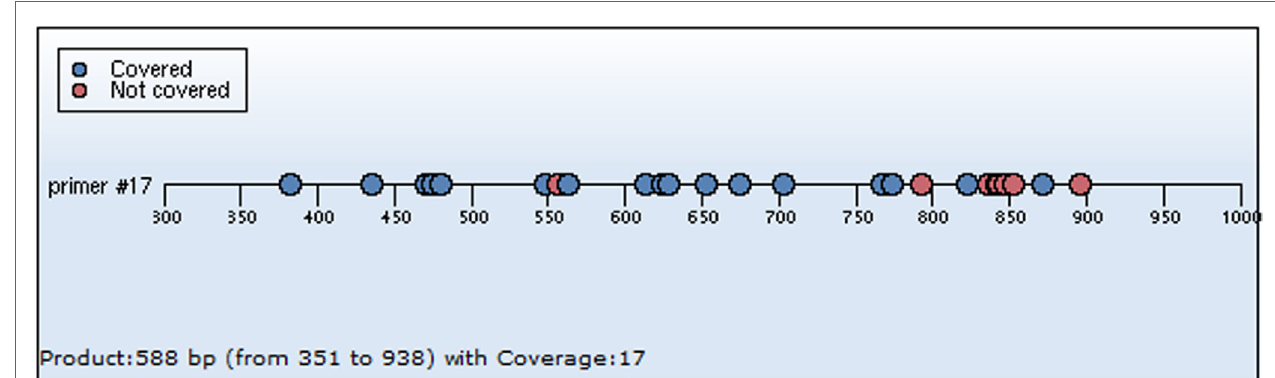
FigUre 2 | Primers were designed based on the sequenom ® EpiDesigner software system. The CpG sites at CpG Island one were involved in the primers design, performed with a program of BDNF #17 was analyzed by the procedures. Each dot indicated one CpG site: the blue dots indicated covered CpG sites, and the red dot covered CpG sites. In this study, the 12 CpG sites situated in the BDNF promoter I are as follows: CpG2, CpG4, CpG5, CpG6, CpG10, CpG11, CpG12, CpG13, CpG14, CpG15, CpG16, CpG18, and